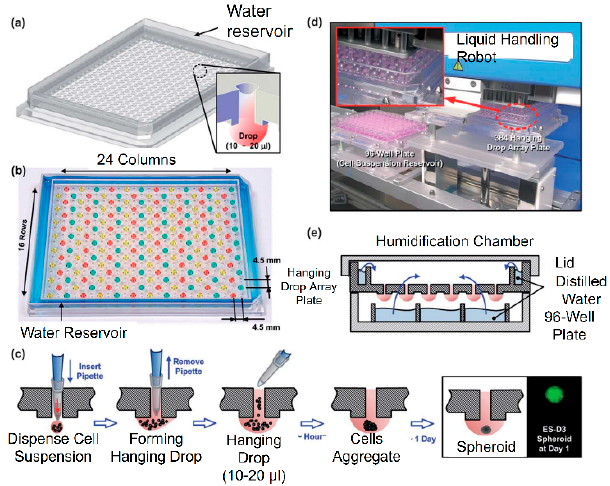
Figure 3. ( a ) The 384 hanging drop spheroid culture array plate designed by Tung. ( b ) The photo of the array plate. ( c ) The hanging drop formation process in the array plate. ( d ) The arrays plate operated by liquid handling robot. ( e ) The array plates were cultured in a humidification chamber.